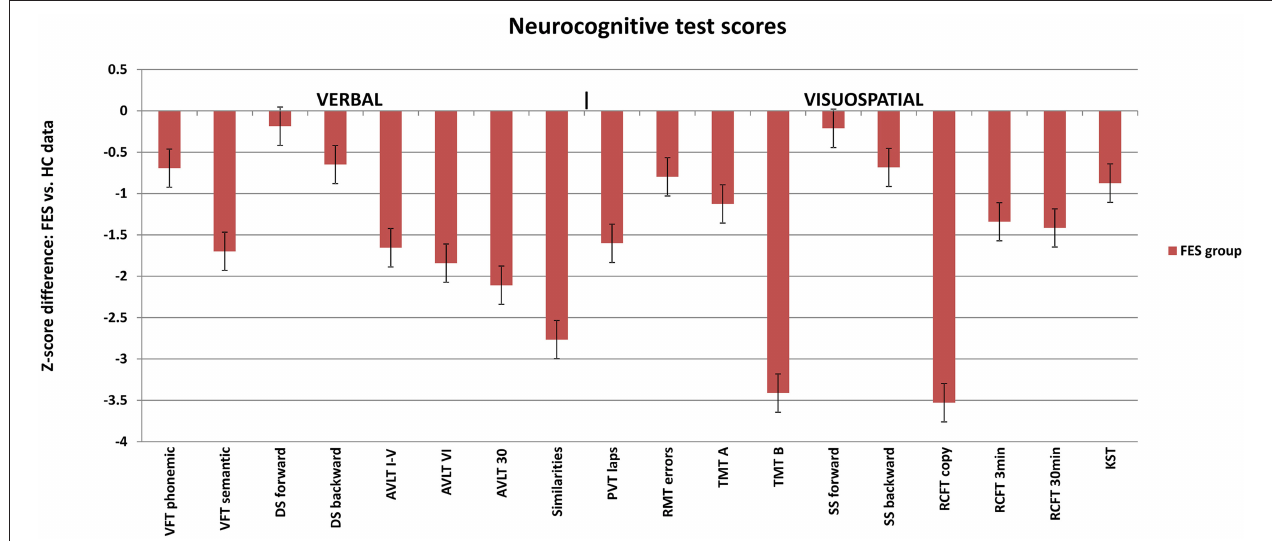
FIGURE 1 | Neuropsychological profile of FES subjects calculated in z-scores for individual test parameters relative to the healthy controls (average Z-score = 0). Selected test results are divided into verbal (left) and visuospatial (right) tests. FES, first psychotic episodes of schizophrenia spectrum disorder; HC, healthy controls; VFT, Verbal Fluency Test; AVLT, Auditory Verbal Learning Test; DS, Digit span; PVT, Perceptual Vigilance Test; TMT, Trail Making Test; RMT, Money Road-Map Test; RCFT, Rey-Osterrieth Complex Figure; SS, Spatial span; KST, Key Search